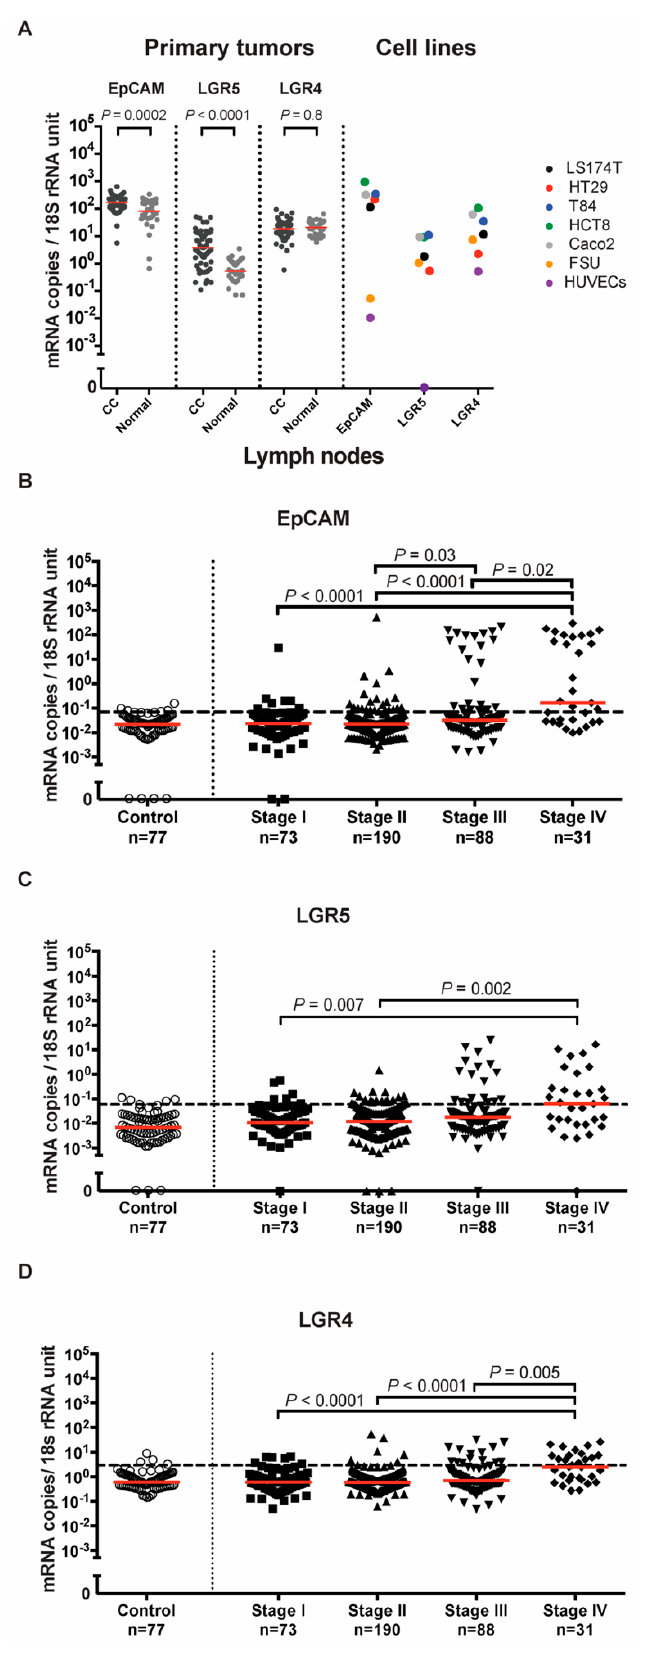
Figure 1. EpCAM, LGR5, and LGR4 mRNA expression levels in tissues and cell lines. ( A )